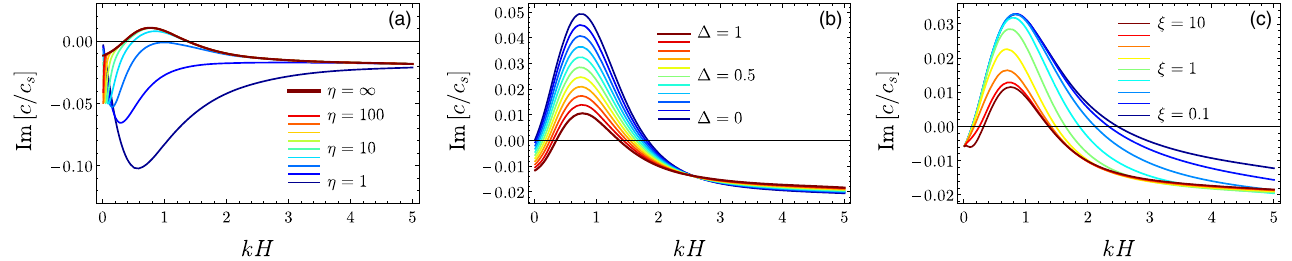
(cid:2) (i.e., the rate of exponential growth or decay of perturbations; Im ½ c (cid:2) > 0 FIG. 5. Linear stability: Generalized analysis. Im ½ c=c s corresponds to instability) vs kH for a broad range of physical parameters. In all panels, the parameters are the same as in Fig. 4 with γ ¼ 3 . (a) The dependence of Im ½ c ð kH Þ =c (cid:2) on η for Δ ¼ 1 . The curve η ¼ ∞ identifies with the blue curve of Fig. 4(a). The case η ¼ 1 s (cid:2) on Δ for ξ ¼ 1 and η ¼ ∞ . (c) The corresponds to a symmetric system and is thus stable for all k . (b) The dependence of Im ½ c ð kH Þ =c s (cid:2) on ξ for Δ ¼ 0 . 5 and η ¼ ∞ dependence of Im ½ c ð kH Þ =c s